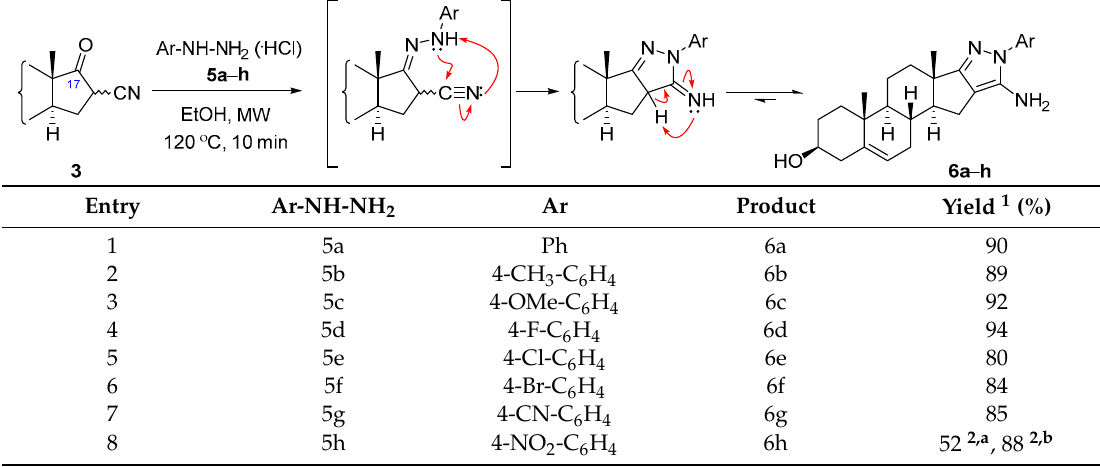
Table 1. Syntheses of D-ring-fused 5-amino-1-arylpyrazoles in the androstane series.